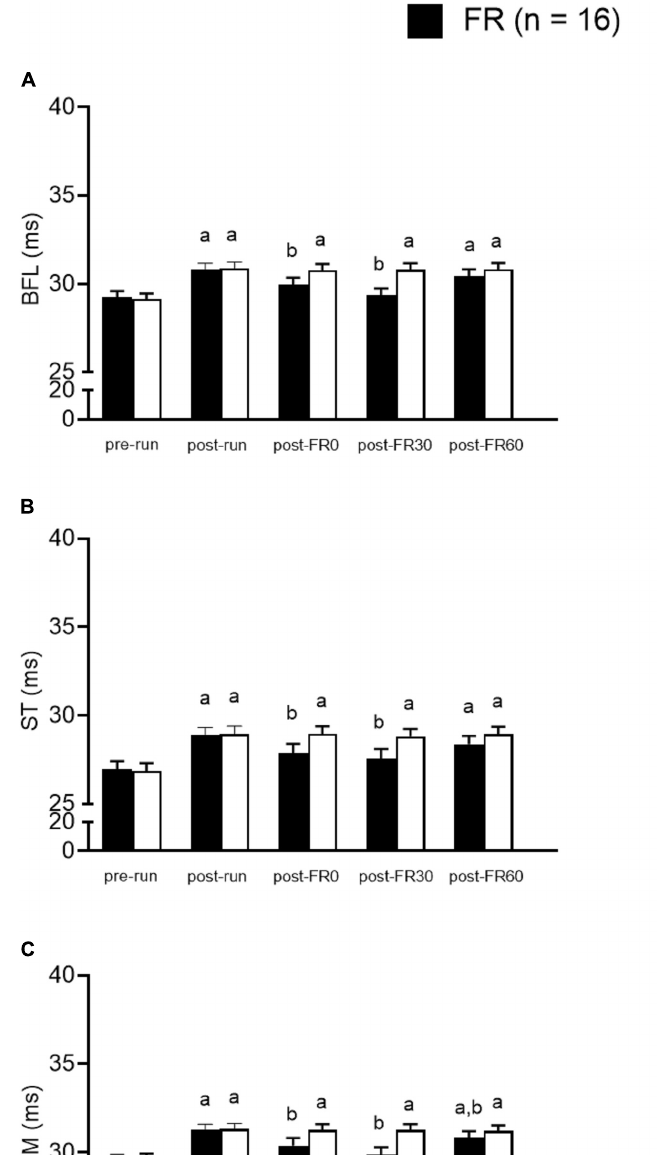
non-invasively evaluate inflammatory edema and microvascular perfusion in hamstrings before and after FR. The microscopic physiological changes of BFL, ST and SM at five time points